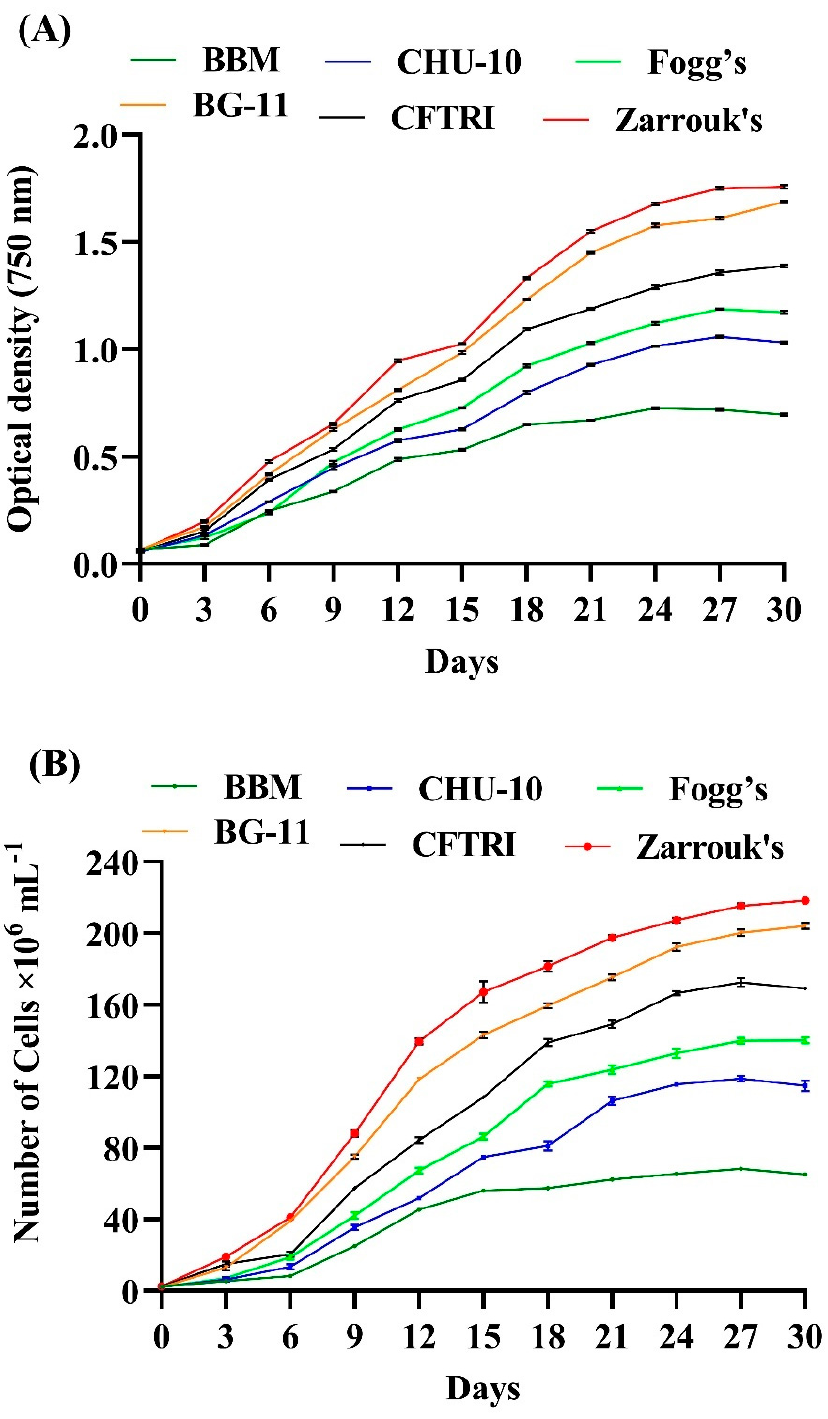
Figure 2. Effect of different growth media on the growth behaviour ( A ) and cell number ( B ) of Scenedesmus rotundus- MG910488.